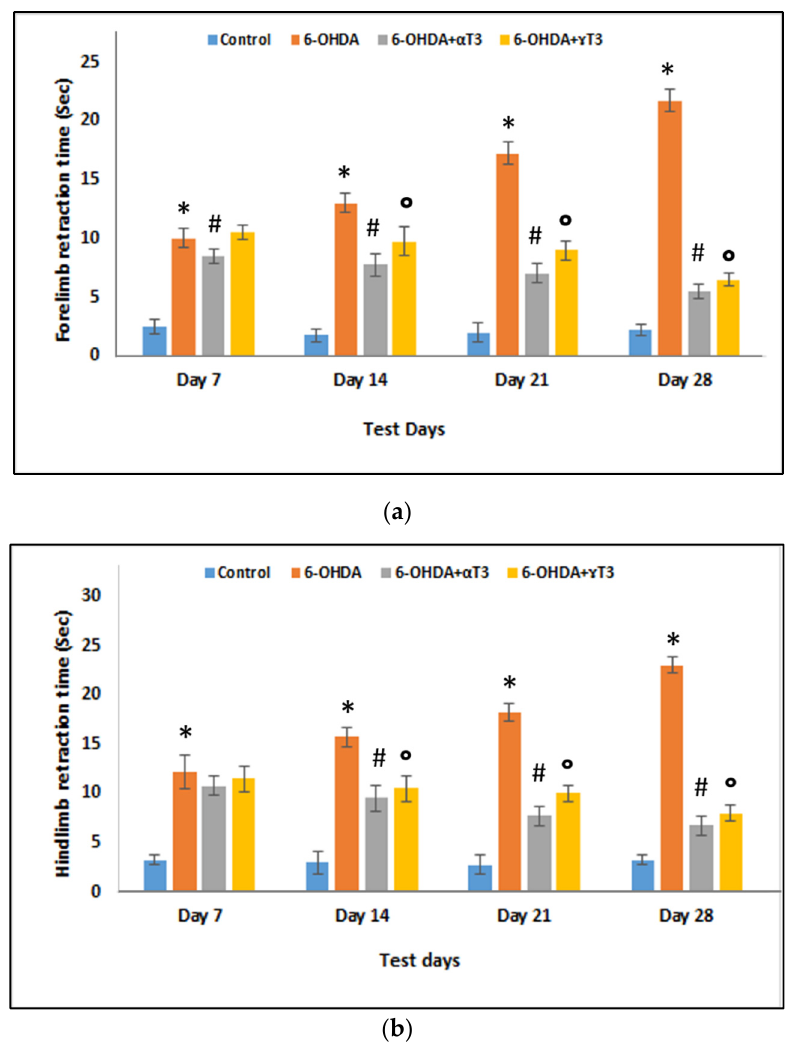
Figure 1. Protective effects of α - and γ -T3 supplementation on ( a ) Forelimb retraction time (FRT) latency and ( b ) Hindlimb retraction time (HRT) latency compared to that in the 250 µ g 6-OHDA- induced parkinsonism group (6-OHDA group). ( n = 6; * p < 0.05 vs. control; # p < 0.05 vs. 250 µ g 6-OHDA; ◦ p < 0.05 vs. 250 µ g